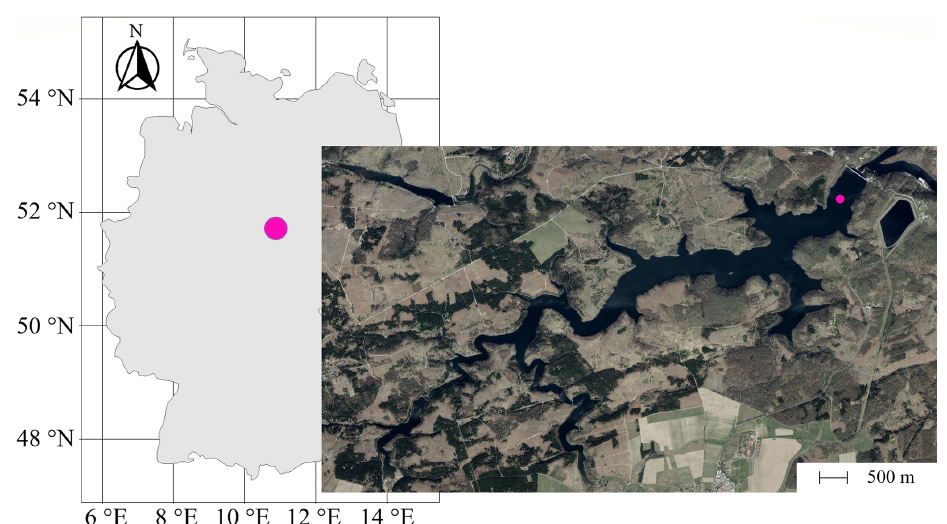
Figure 1. Position of the Rappbode Reservoir in Germany with the sampling location marked by a pink point in the main reservoir (source: